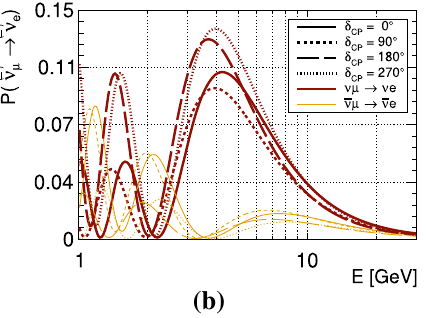
Fig. 6 a Probabilitiesfor ν μ ’s(darkcolourscatterplots)and ¯ ν μ ’s(light colour scatter plots) to oscillate to each neutrino flavours as function of the neutrino energy and for all possible values of δ CP . b Probabilities for a ν μ ’s (dark red thick lines) and ¯ ν μ ’s (yellow thin lines) to oscillate to the electron neutrino flavour as a function of the neutrino energy.